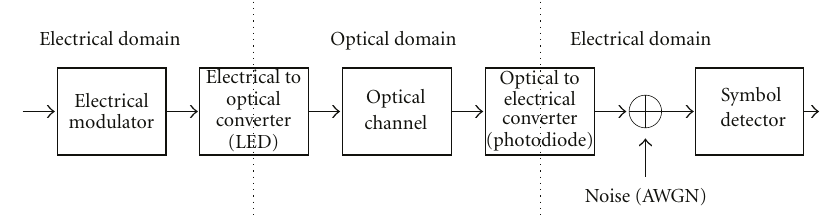
Figure 1: Block diagram of intensity modulated/direct detection (IM/DD) DOW communication system.